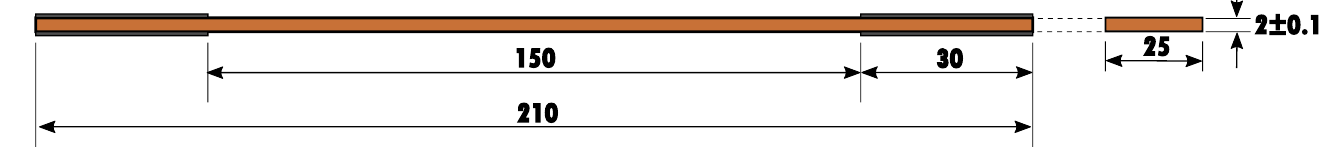
Figure 4. Technical drawing of a tensile specimen. Dimensions in